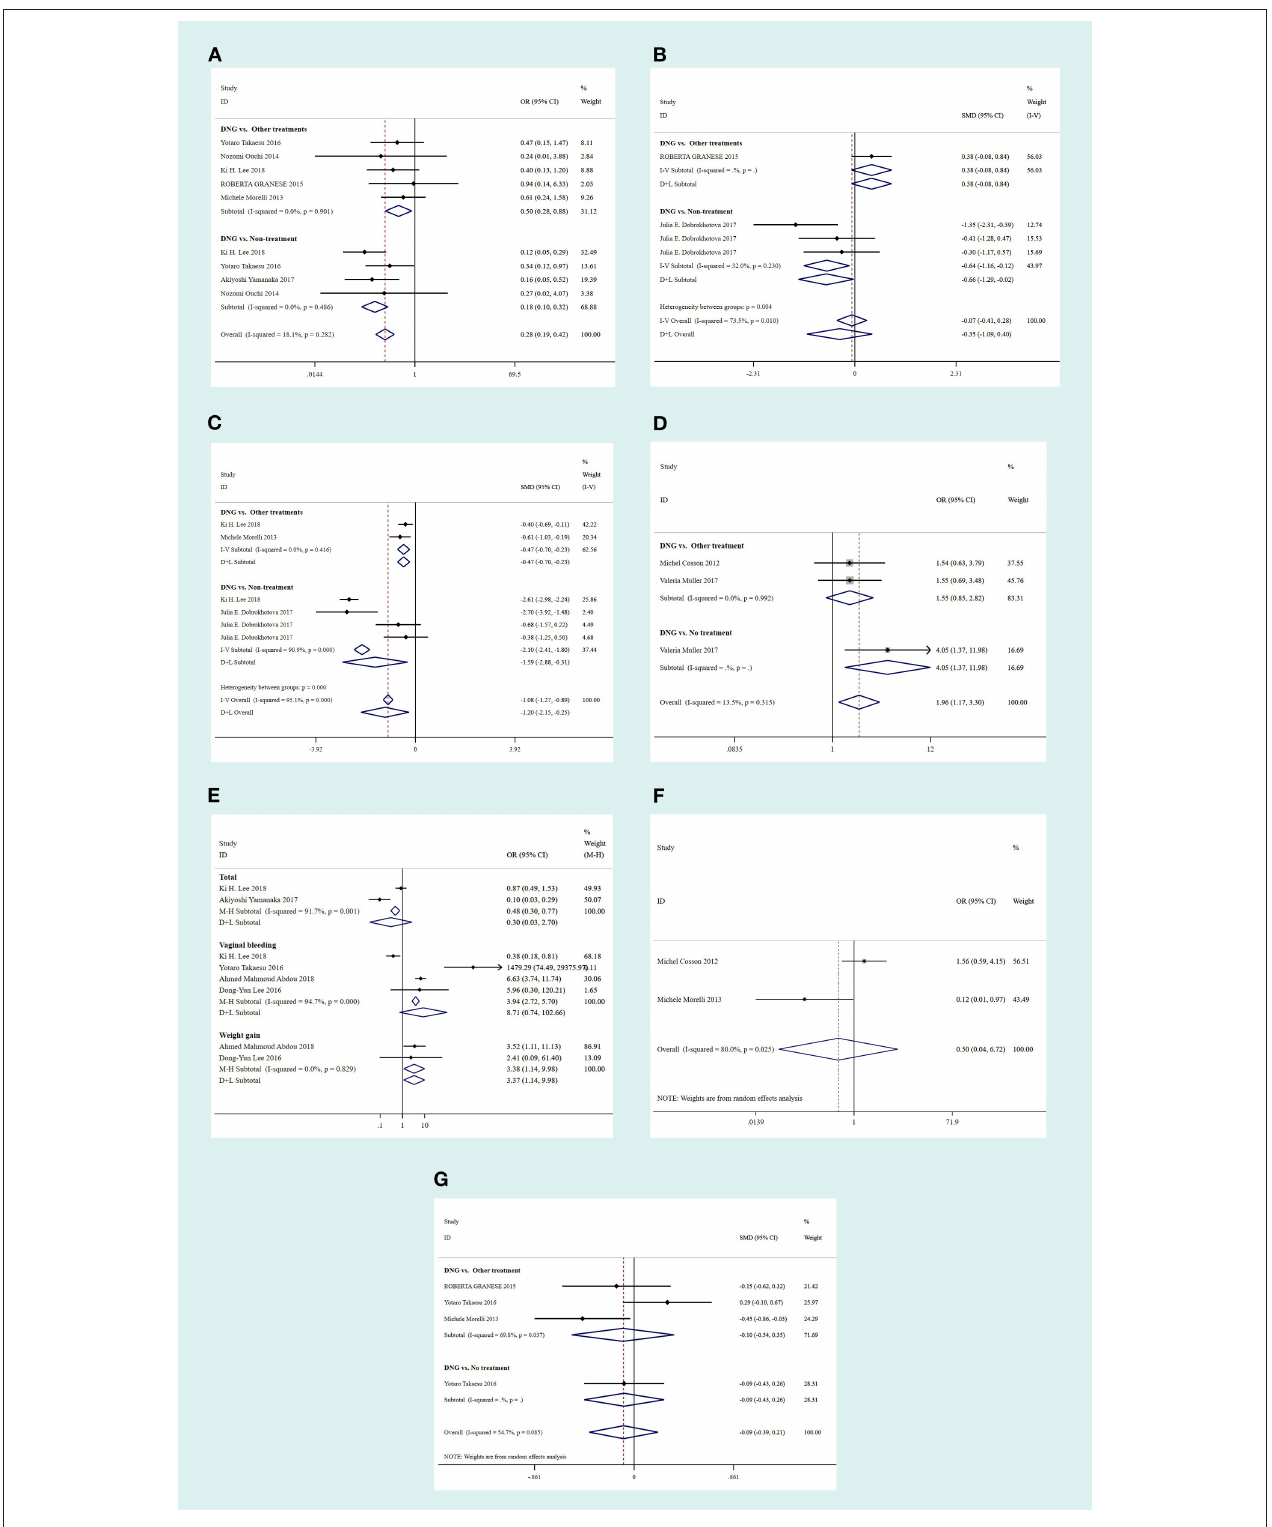
FIGURE 2 | Forest plots of outcomes comparing the Dienogest (DNG) group with the control group in terms of disease recurrence (A) , 3-month VAS scores (B) , 12-month VAS scores (C) , adverse effects (D) , pregnancy rates (E) , patient satisfaction (F) and CA125 levels (G) . CI, confidence interval; OR, odds ratio; SMD, standardized mean